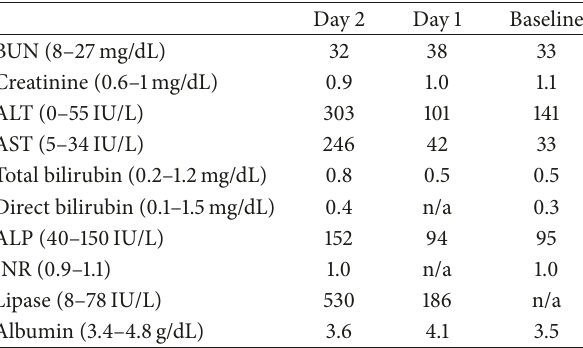
Table 1: Summary of laboratory results.